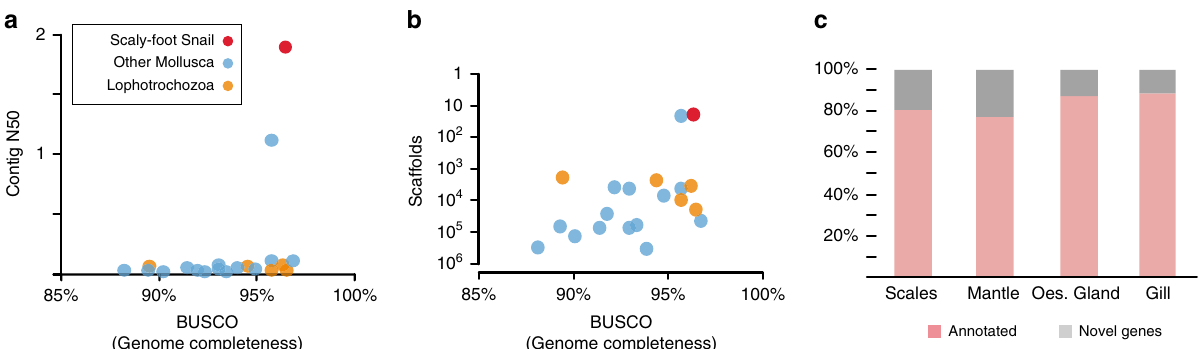
Fig. 2 Summary of the Scaly-foot Snail genome. a , b Quality comparisons between the Scaly-foot Snail genome and other available lophotrochozoan genomes: a Contig N50 vs BUSCO (Benchmarking Universal Single-Copy Orthologs); b Number of scaffolds vs BUSCO (for full comparison see Supplementary Table 2). Red dot indicates the Scaly-foot Snail genome, blue dots indicate other molluscan genomes, orange dots indicate other non- molluscan lophotrochozoan genomes. c Proportion of annotated genes (pink) and novel genes (grey) in four key tissue types of the Scaly-foot Snail, including scale-secreting epithelium, shell-secreting mantle, oesophageal gland (oes. gland), and gill. Source data are provided as a Source Data